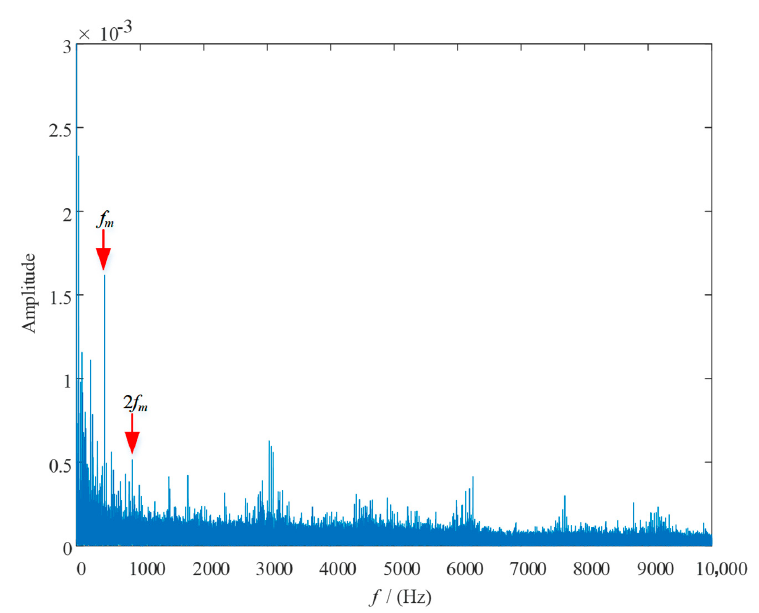
Figure 18. Test signal in the healthy condition.